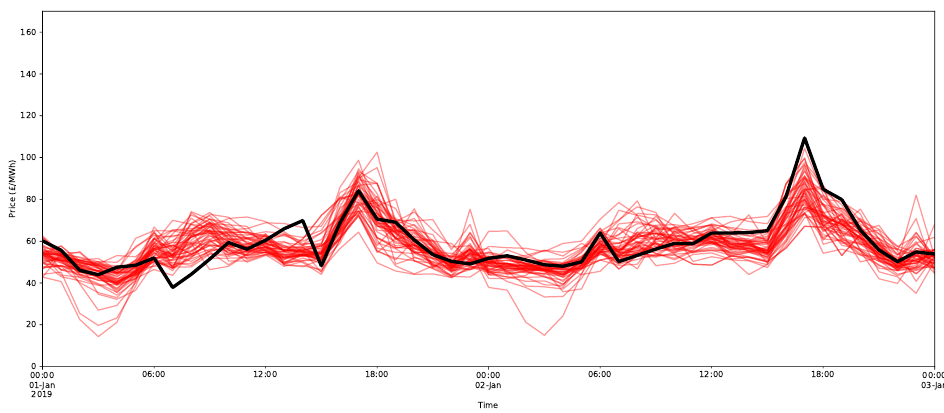
Figure 22. Example of 50 ensembles (red) for the ARX method for the first day of the test set. The actual price is in black.